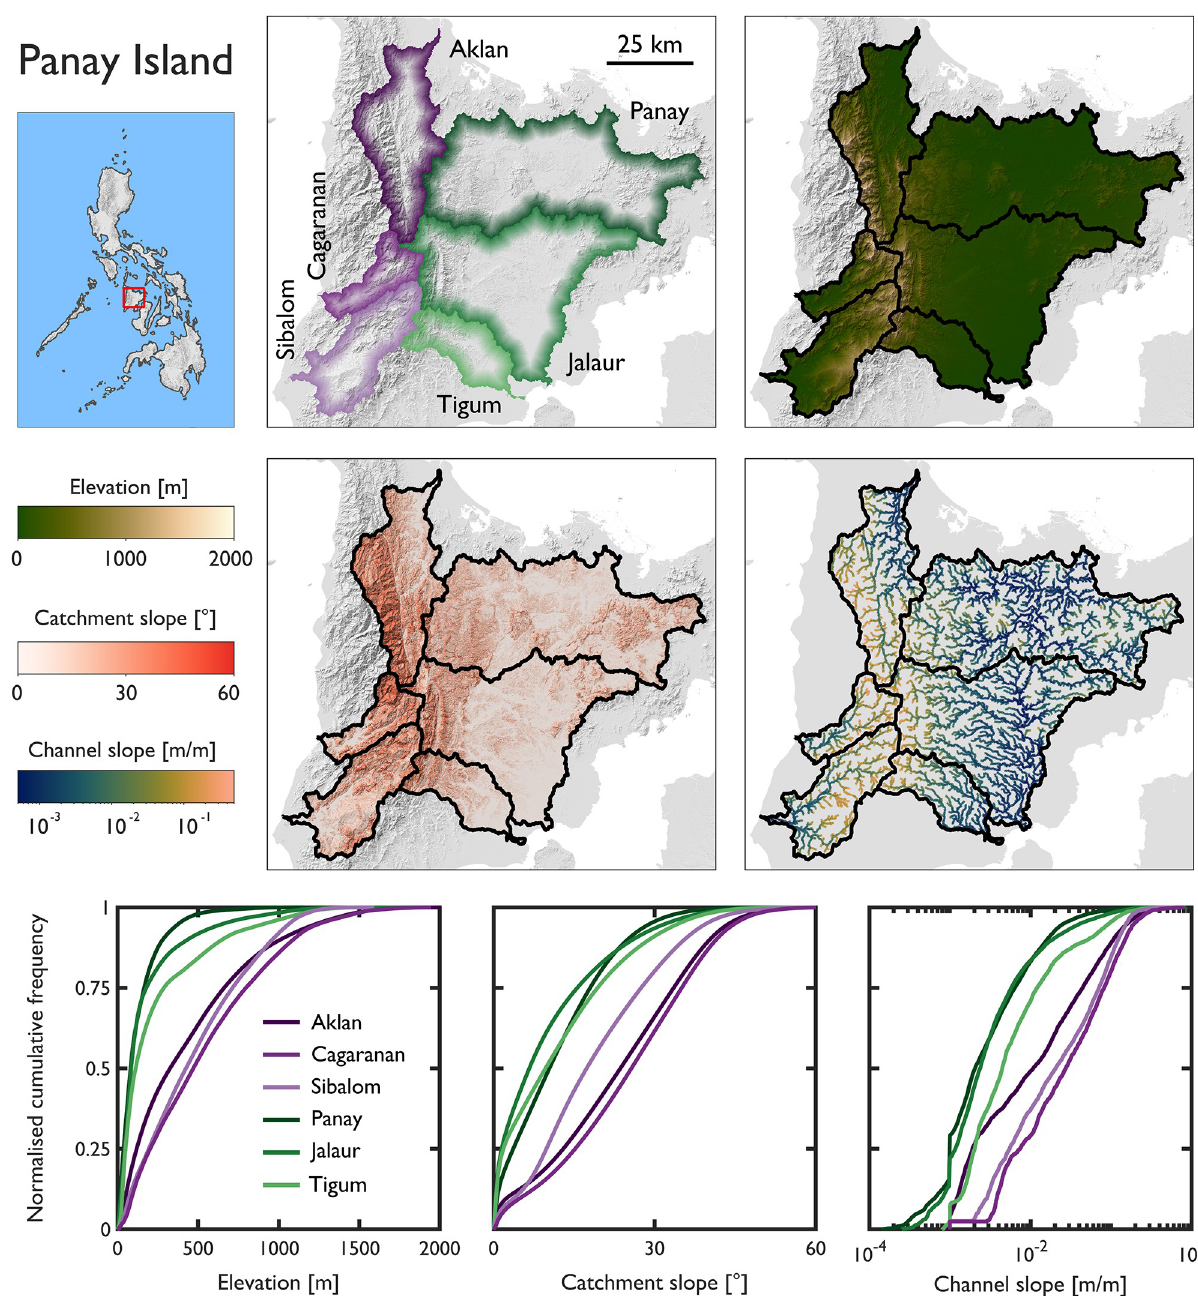
Fig 8. Inter-catchment comparisons of topographic diversity for six catchments on Panay Island, the Philippines. All catchments have headwaters in the Central Panay Mountain Range.